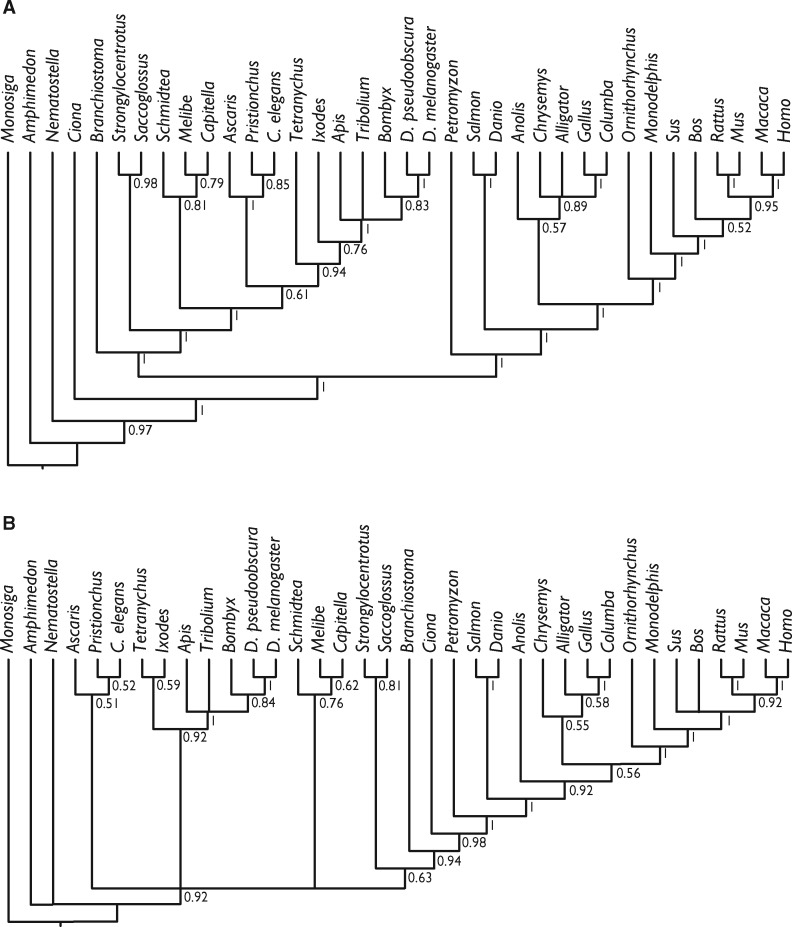
—Phylogenetic tree derived from the Dollo analysis of the curated presence/absence of microRNA families considered in our analysis. (A) Shows results whereby all miRNAs were included and (B) where singletons (synapomorphic) miRNAs were excluded. Node values are clade posterior probabilities.